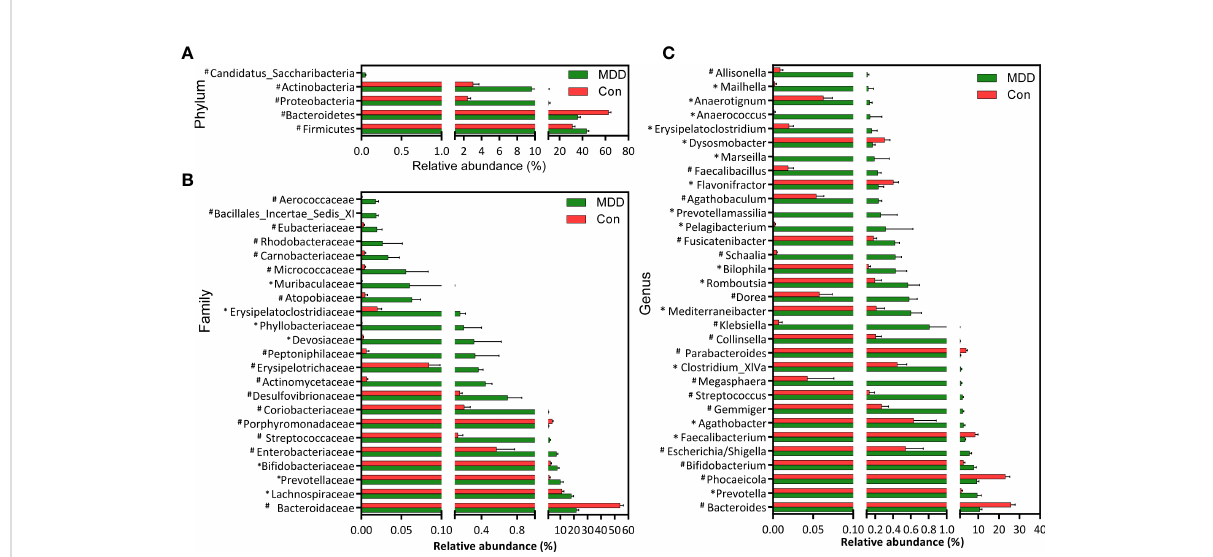
FIGURE 3 Differential bacterial taxa between childhood MDD patients and the healthy controls. Comparisons of the relative abundance of the abundant bacterial taxa at the level of bacterial phylum (A) , family (B) , and genus (C) . The data are presented as the mean ± standard deviation. Mann – Whitney U -tests were used to analyze variation between childhood MDD patients and the healthy controls. *p < 0.05 and # p < 0.01 compared with the control group.